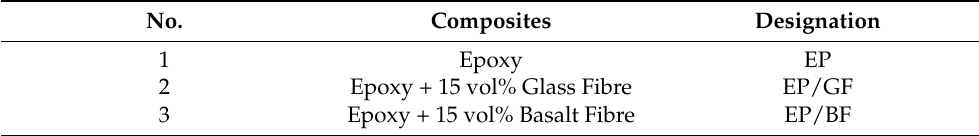
Table 1. Composition and designation of the composites.